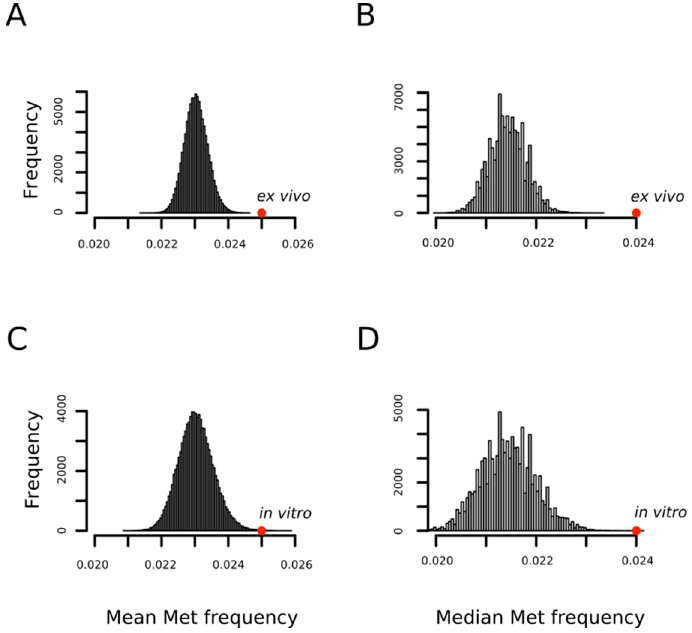
Figure 2. MetO-containing proteins are enriched in methionine residues. Empirical distributions of mean and median methionine content for 100,000 random samples from the human proteome. For each sample, both the mean ( A , C ) and the median ( B , D ) of the relative frequency of methionine were obtained by averaging across either 1113 ( A , B ) or 503 ( C , D ) proteins randomly chosen from the human proteome. The positions of the mean and median values computed for the set of 1113 proteins oxidized ex vivo ( A , B ) and for the set of 503 proteins oxidized in vitro ( C , D ) are indicated with the red circles.